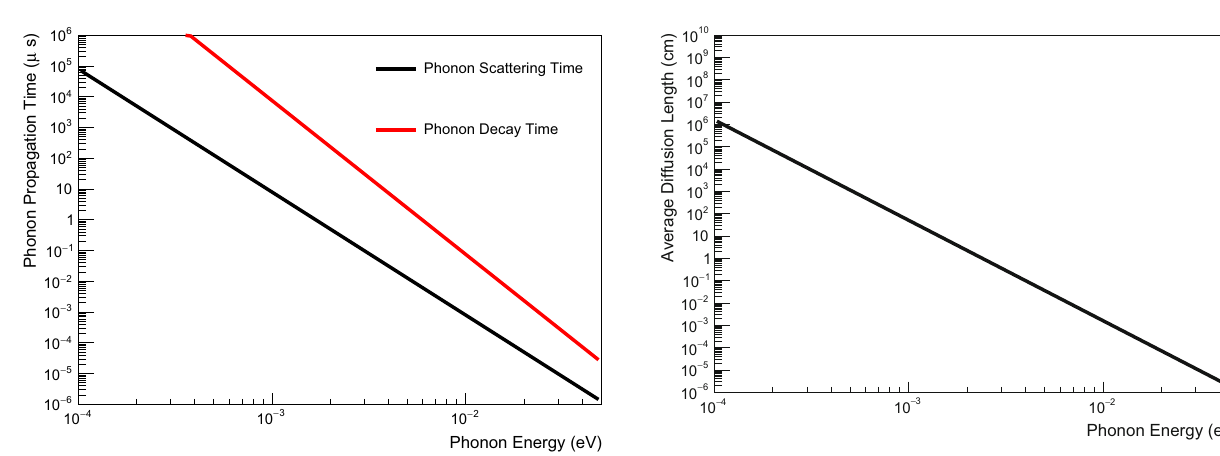
Fig. 6 Shown is the timescale for the elastic scattering and the anhar- monic decay process as a function of phonon energy